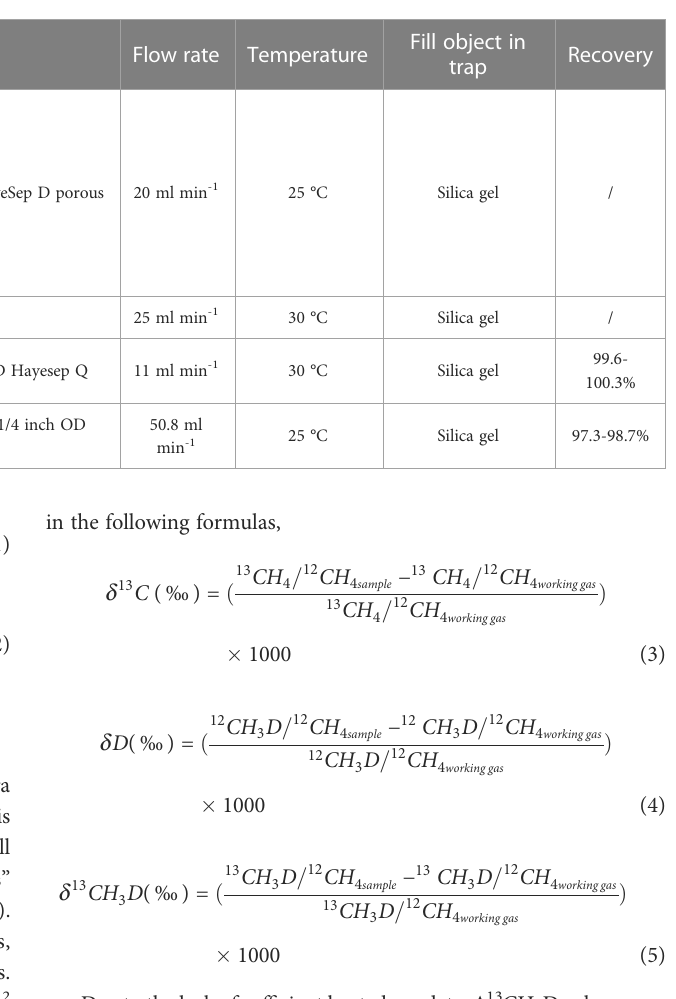
TABLE 2 Technique parameters of various GC-based methane puri fi cation